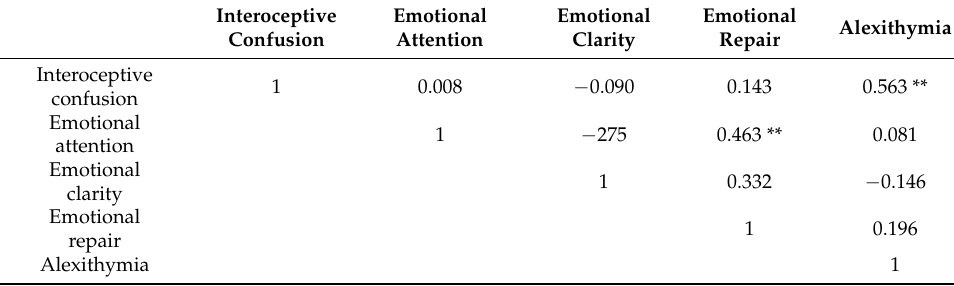
Table 3. Spearman’s correlation for the CG.